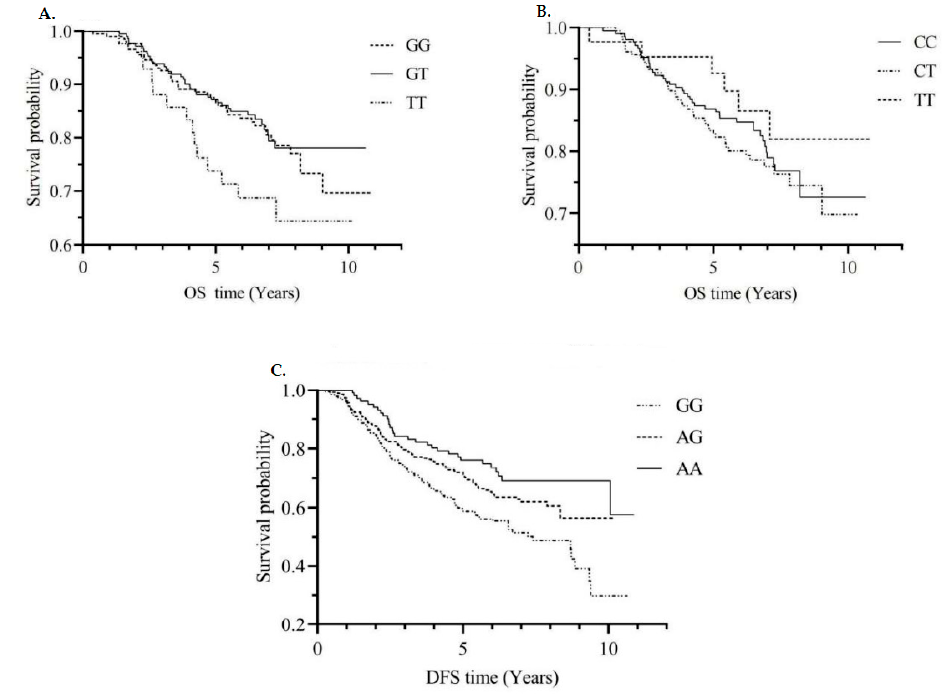
Figure 1. CRC-specific survival curves by MTHFR rs4846049 genotype ( A ); CRC-specific survival curves by MTHFR rs1801133 genotype ( B ); DFS curves by MTRR rs1801394 genotype ( C ). Abbreviations: CRC = colorectal cancer; MTHFR = methylenetetrahydrofolate reductase; OS = overall survival; DFS = disease-free survival. GG, GT and TT; CC, CT and TT; GG, AG and AA are genotypes of